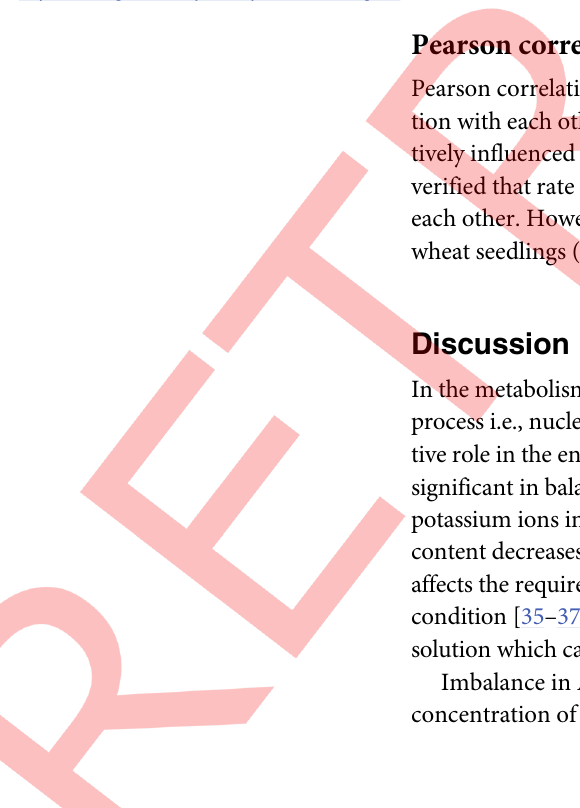
Fig 7. Principal component analysis for the effect of salinity on germination and seeding growth of four wheat varieties.